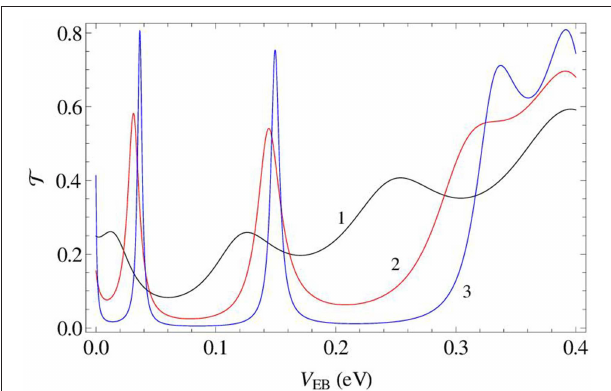
FIGURE 6 | Transmission amplitude T as a function of emitter-to-base a 3 voltage V EB for parameter values: E 0.1 eV, a 1 0.5 eV, a 2 0, = = = = V CB d 3 0.2 eV, d 1 2 nm, d 2 10 nm. Computations have been = = = = ν 1 µ 3 ν 3 carried out with powers µ 1 1 (points P 1,1 ) and µ 2 2, = = = = = ν 2 0. Squeezing scenario is displayed for ε 0.5 (curve 1, black), 0.25 = = (curve 2, red), and 0.1 (curve 3, blue). Location of all three peaks